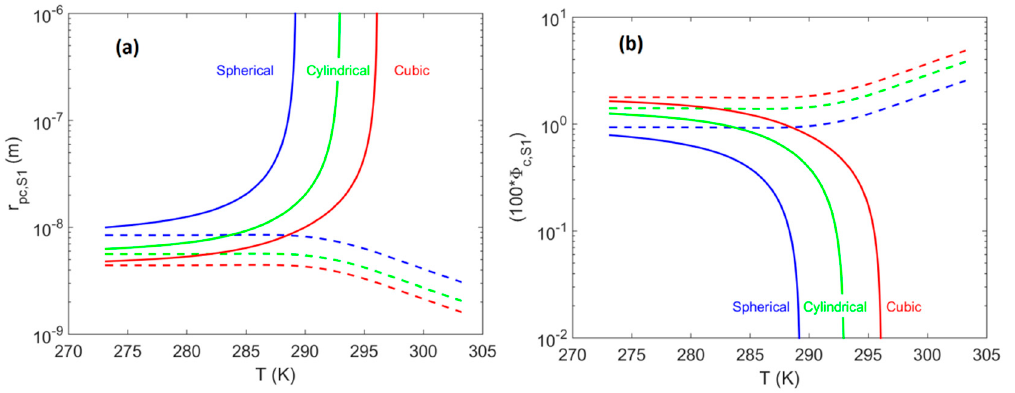
Figure 6. System of a single pore-body (i.e., system S1). ( a ) Effect of pore-body geometry (spherical— blue; cylindrical—green; cubic—red) on the critical pore-body radius, r pc , S 1 , plotted as a function of temperature along the three-phase (H–L w –V) equilibrium line for the methane + water system (modified from Tsimpanogiannis [60]). ( b ) Effect of pore-body geometry for system S1 on the value of ( 100 ∗ Φ ) , plotted as a function of temperature along the same three-phase equilibrium line. Solid lines correspond to pores located at the hydrate-dissociation front ( P l = P bulk eq ) , while the dashed lines correspond to pores at minimum pore pressure ( P l = 0 ) for well production via a pressure depletion scheme.